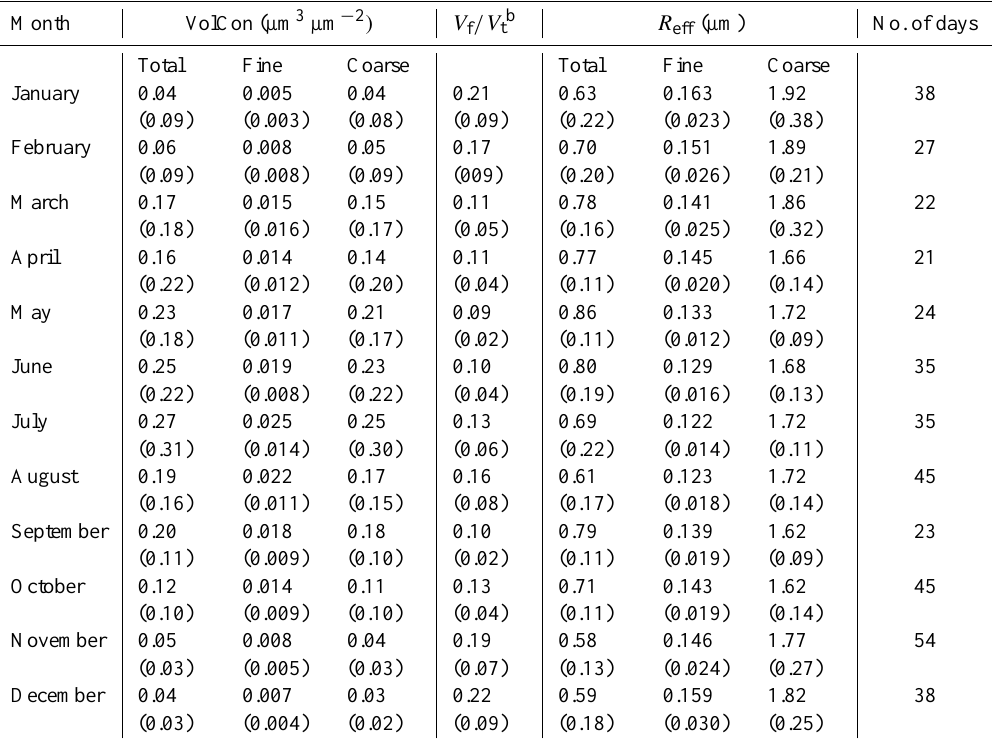
Figure 7. (a) Monthly means of aerosol particle size distribution (µm 3 µm − 2 ) at Tamanrasset for the period 2006–2009. Same colours are used for the dry season (blue), the wet season (orange), and the transition months (grey). (b) Scatter plot of FMF (dimensionless) and fine mode volume fraction ( V f /V t ) (dimensionless) for the dry and wet seasons (157 and 183 coincident observations, respectively). Table 5. Monthly means of volume particle concentration (VolCon) of total, fine and coarse modes, fine mode volume fraction ( V f /V t ), and effective radius ( R eff ) for the period October 2006–February 2009 at Tamanrasset a